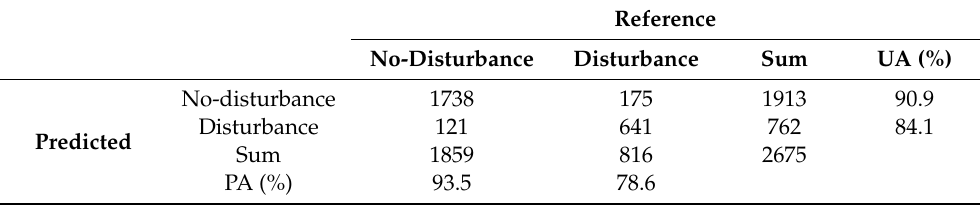
Table 1. Confusion matrix of RF disturbance probability model for each observation at the single pixel of Landsat 8. Observations that had disturbance probabilities of greater than 50% were labeled as disturbances.